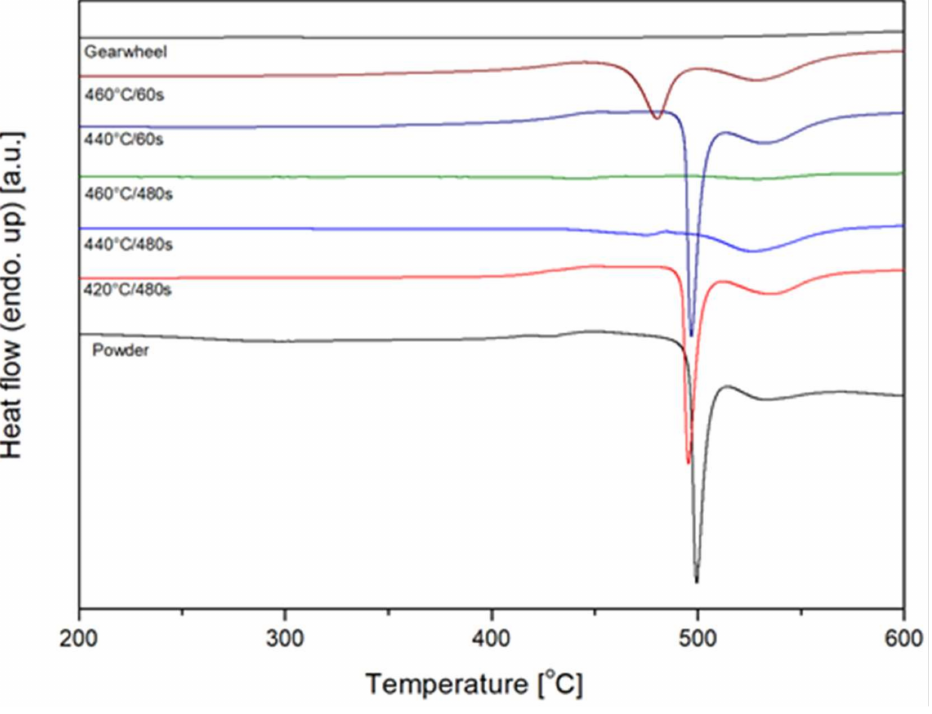
Figure 12. DSC patterns of raw powder and sintered